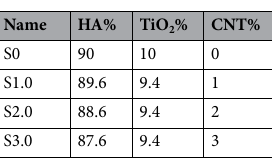
Table 1. Percentage of each material in the HA/TiO 2 /CNT